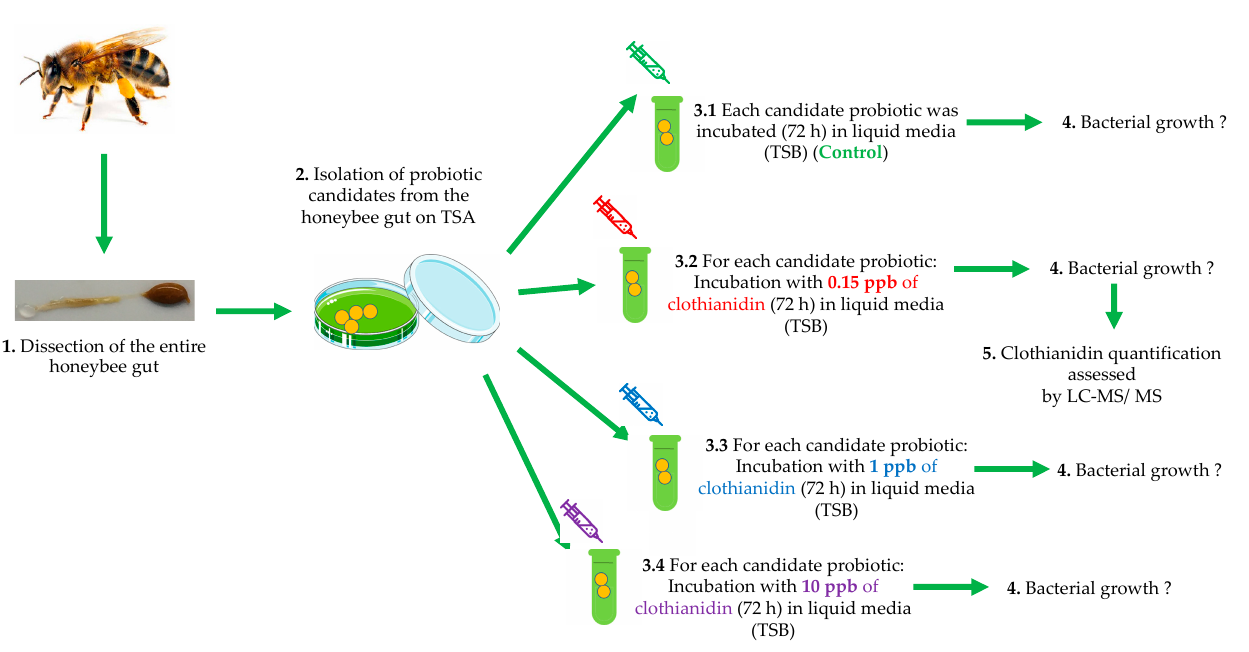
Figure 1. Experimental schema of the in vitro design (from left to right): (1) We started by isolating and dissecting 60 entire honeybee guts; we then (2) selected the bacterial probiotic candidates (PC) used in the study; (3) we incubated the isolated PC with (3.1) TSB media (control); and with three sublethal doses of clothianidin (0.15 ppb) (3.2); 1 ppb (3.3) and 10 ppb (3.4); (4) we monitored PC bacterial growth rate 72 h in all four conditions; and, finally, (5) we assessed clothianidin quantification with LC-MS/MS to measure degradation by the PC.